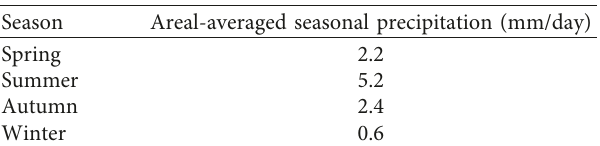
Figure 2: Spatial patterns of mean seasonal precipitation (mm/day) derived from the CHIRPS dataset over the Han River basin for the period of 1981–2010. (a) Spring. (b) Summer. (c) Autumn. (d) Winter. Table 1: Areal-averaged seasonal precipitation over the Han River